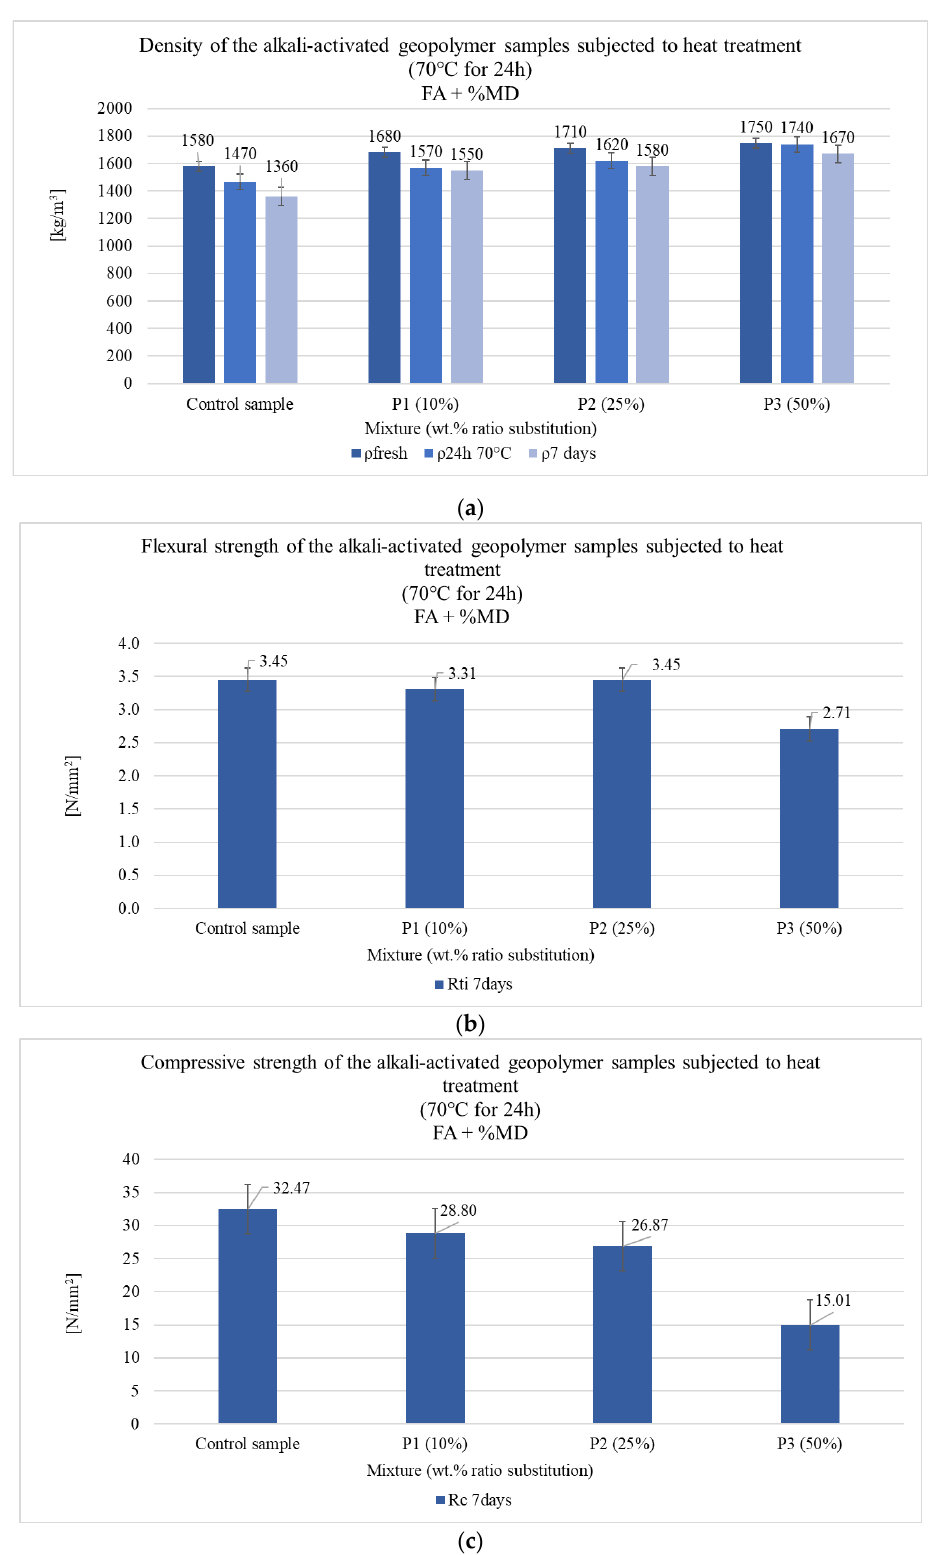
Figure 1. Physico-mechanical performances of the alkali-activated geopolymer binder using MD as FA substitution subjected to heat treatment: ( a ) Apparent density; ( b ) Flexural strength and ( c ) Compressive strength.